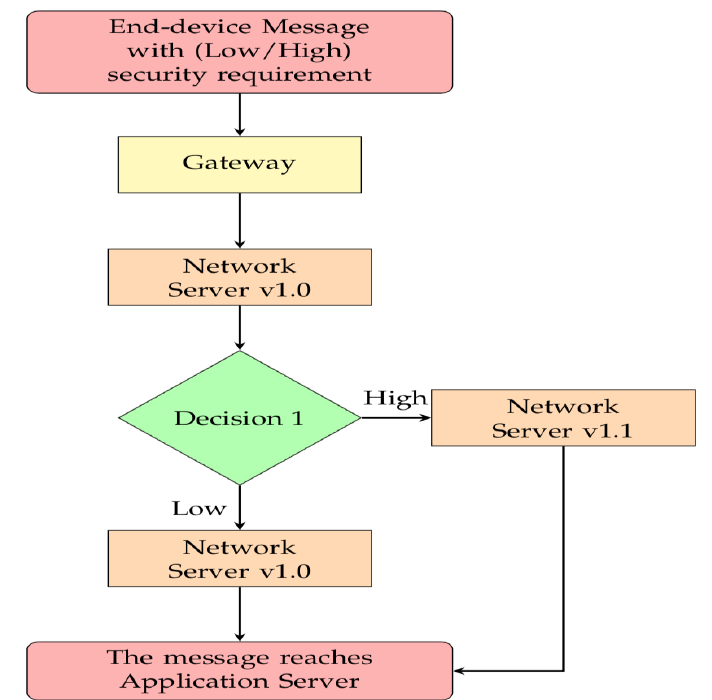
Figure 4. Flowchart for ensuring the Backward Compatibility in